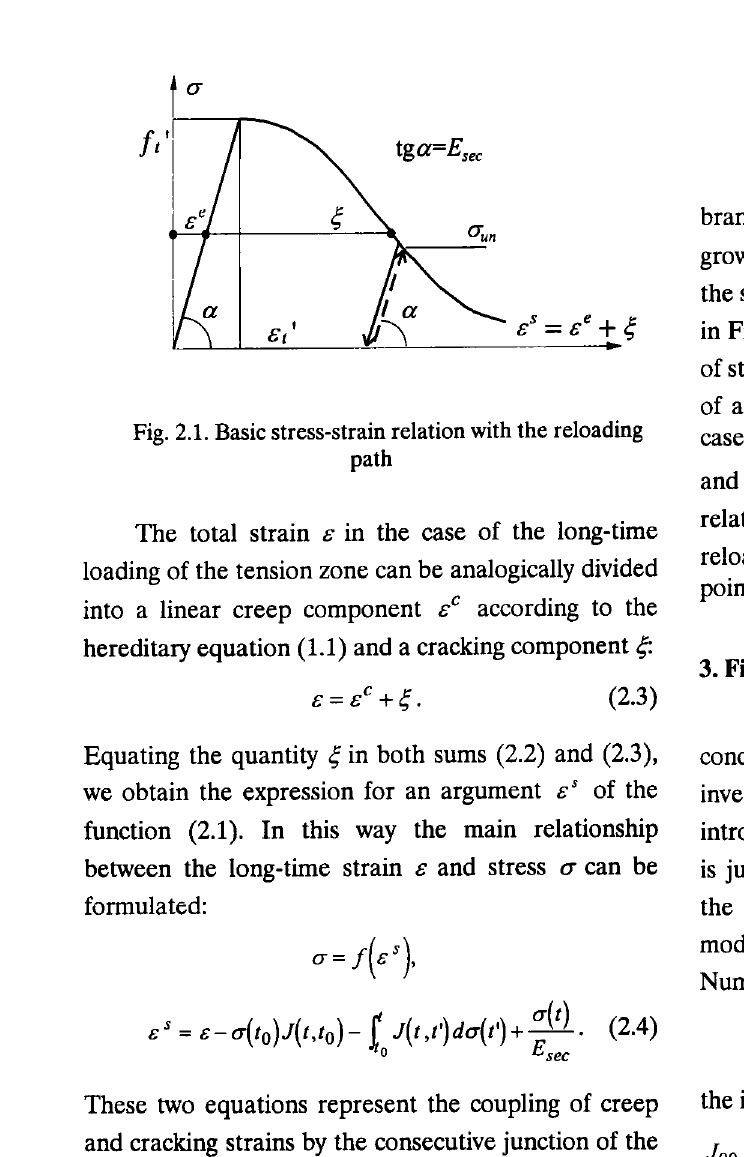
Fig. 2.1. Basic stress-strain relation with the reloading